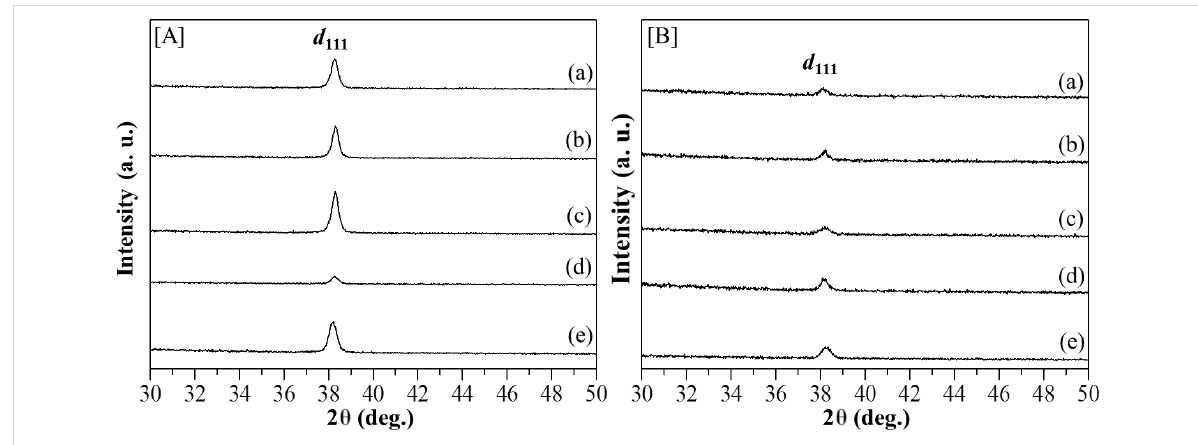
Figure 6: XRD patterns for the wide-angle region of a) [AuNPs] cal /silica hex and b) [AuNPs] red /silica hex at (a) 190, (b) 210, (c) 230, (d) 250 and (e) 450 °C.